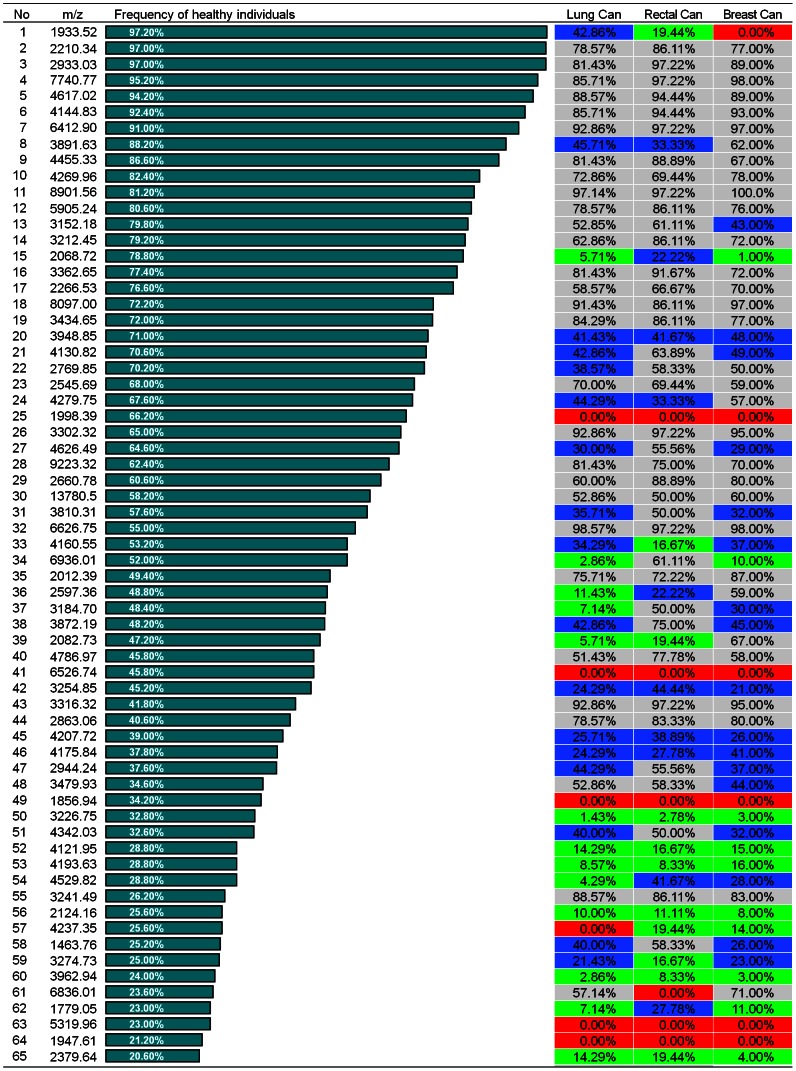
Occurrence frequency of 65 peptides in the sera of healthy individuals and patients with three types of cancer.m/z (mass:charge ratio) indicates protonated average molecule weight (M+H) in linear MALDI-TOF-MS. Red: zero frequency in cancers; Green: <20% frequency; Blue: 20–50% frequency; Grey: >50%.